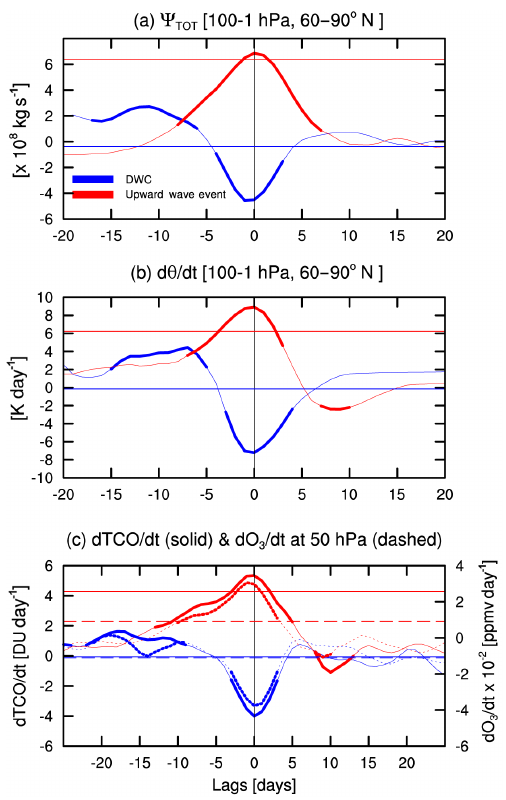
Figure 8. Same as Fig. 4, but from a 100-year CESM1(WACCM)